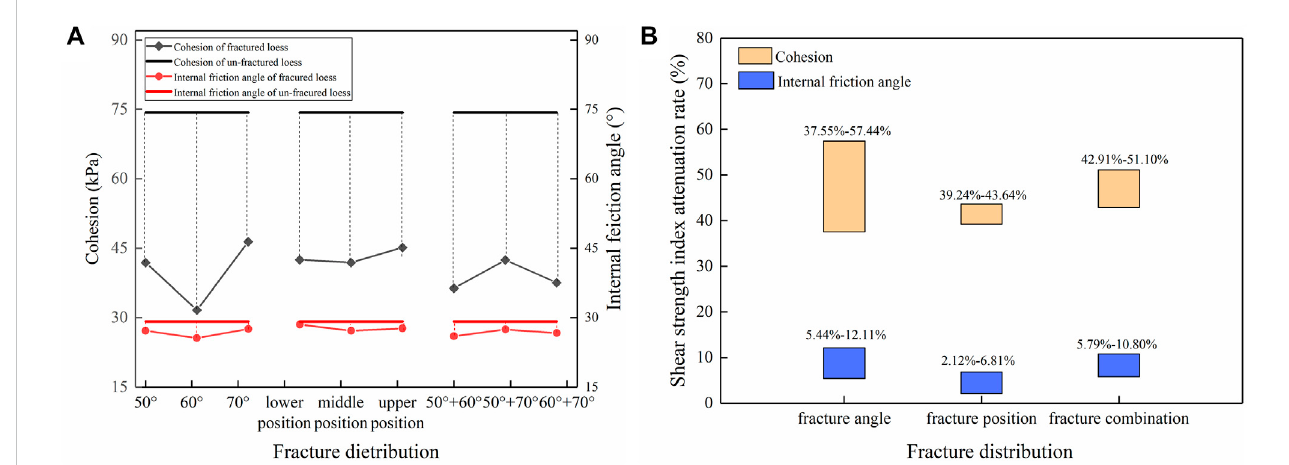
FIGURE 8 Curveofcohesionandinternalfrictionangleoffractureloesswithdifferentfracturedistributionpattern. (A) shearstrengthindex; (B) shearstrengthindex attenuation rate.